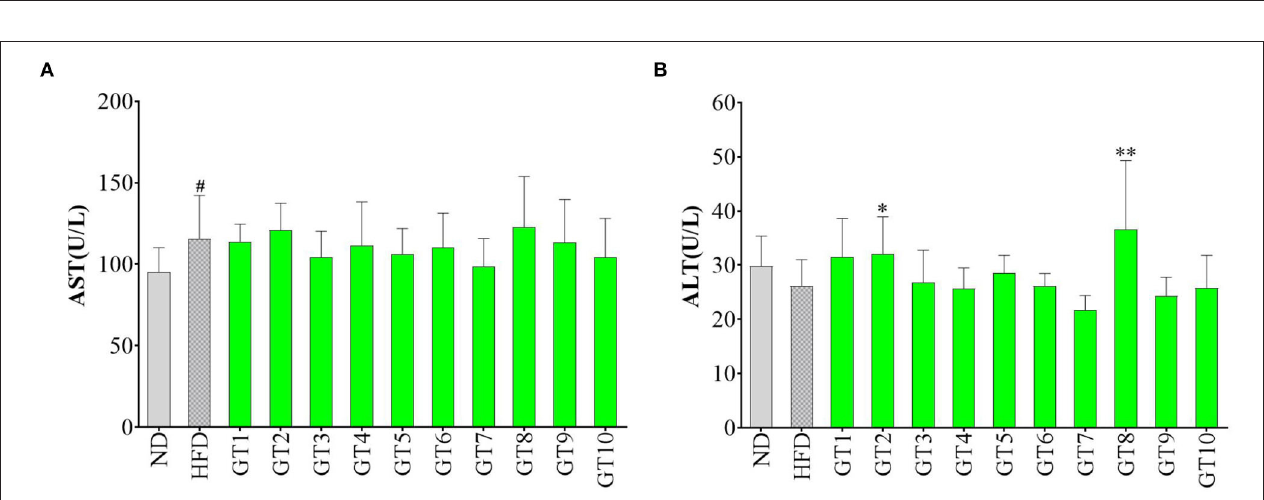
FIGURE 5 | Effects of green teas on liver injury. (A) Serum AST level and (B) Serum ALT level. # p < 0.05, the model group vs. the control group; * p < 0.05, ** p < 0.01, the green tea groups vs. the model group. AST, aspartate transaminase; ALT, alanine aminotransferase; ND, normal diet; HFD, high-fat diet; GT1, Dianqing Tea; GT2, Jieyang Chaoqing Tea; GT3, Fenggang Zinc-Selenium-Enriched Tea; GT4, Liping Xiang Tea; GT5, Taiping Houkui Tea; GT6, Xihu Longjing Tea; GT7, Chaoqing Green Tea; GT8, Selenium-Enriched Chaoqing Green Tea; GT9, Selenium-Enriched Matcha; GT10, Seven Star Matcha.